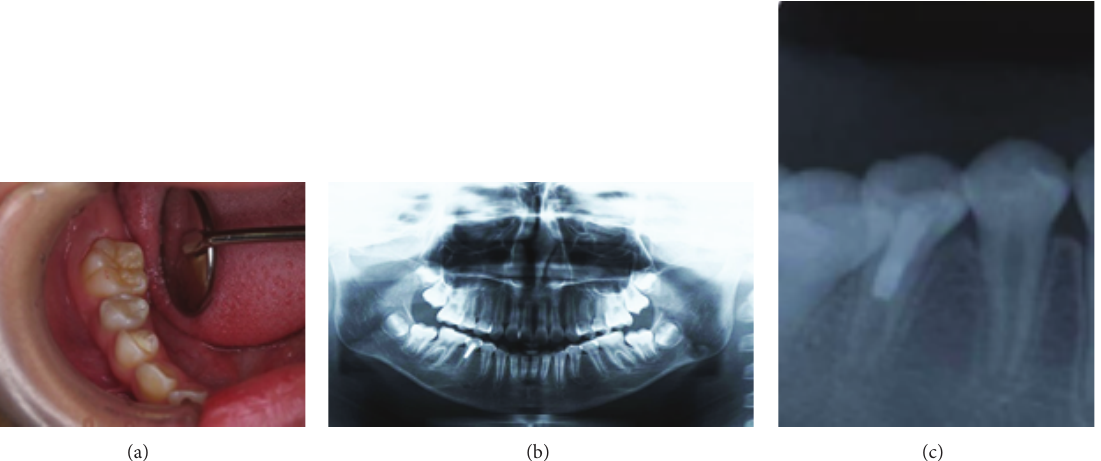
Figure 3: (a) Intraoral photograph showing no abnormalities of gingiva. (b) Panoramic X-ray photograph showing the formation of a dentin bridge in the mandibular right second premolar. (c) X-ray shows that radiolucency became less radiolucent in the periradicular region and the formation of a dentin bridge in the mandibular right second